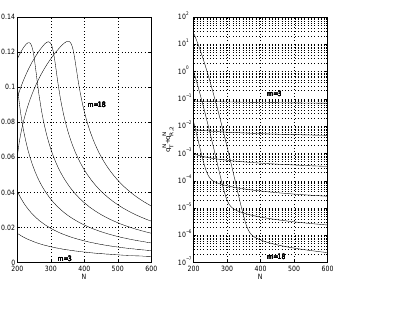
m=18m=3 m=18m=3 m=18m=3